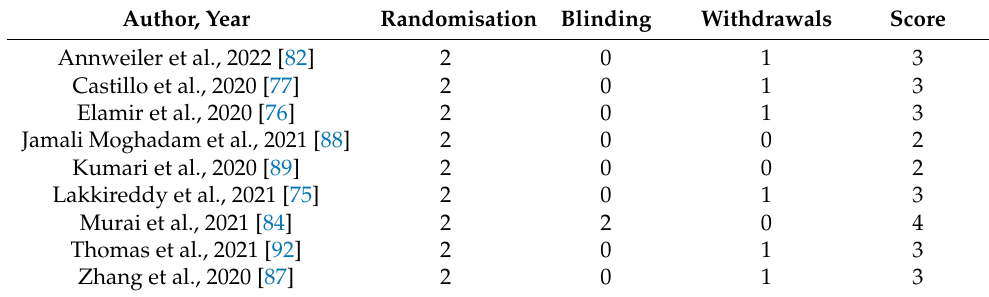
Table 4. Jadad Composite